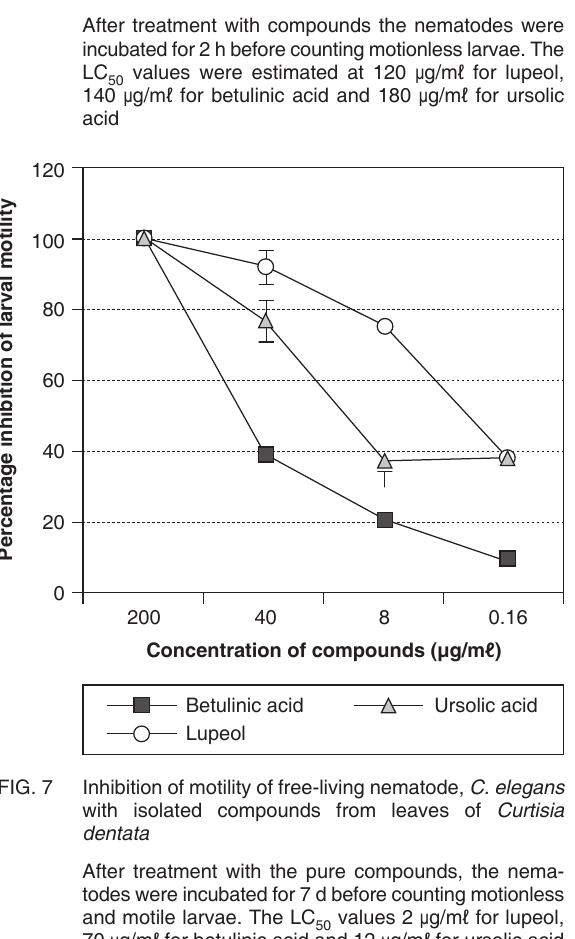
isolated from Curtisia dentata leaves